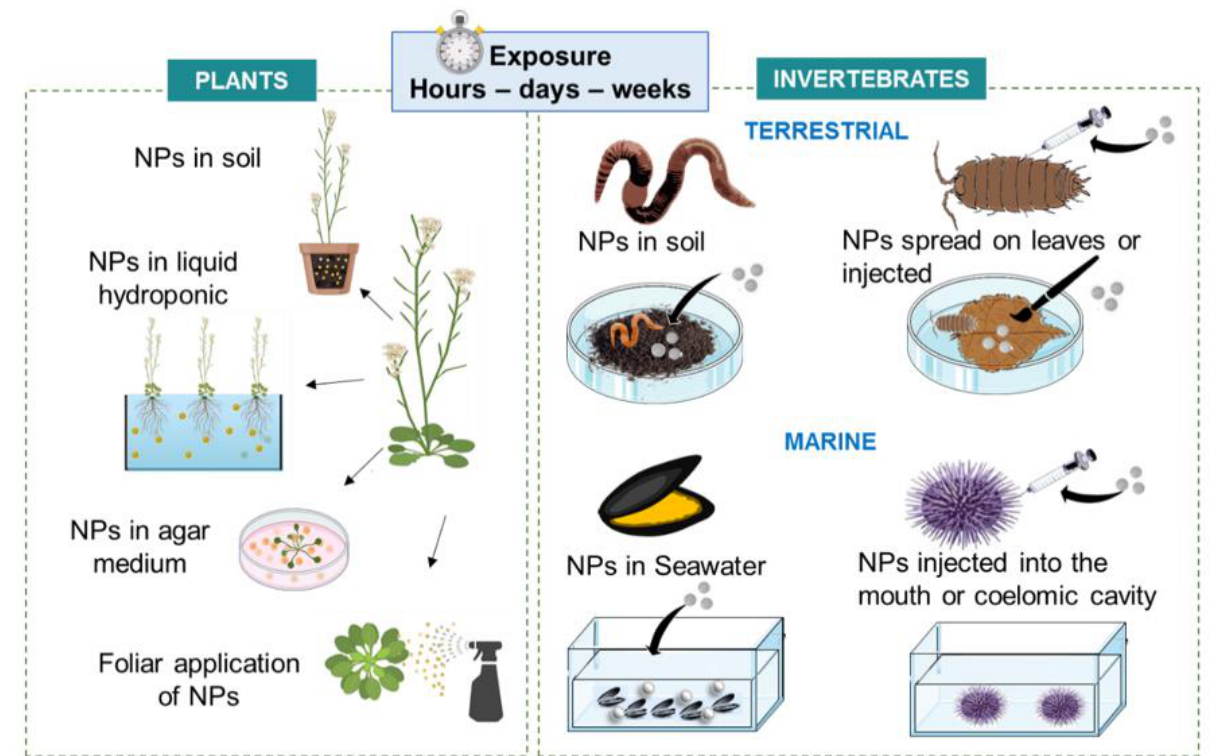
Figure 6. NP exposure approaches using the whole organism with the different exposure pathways across the selected models.